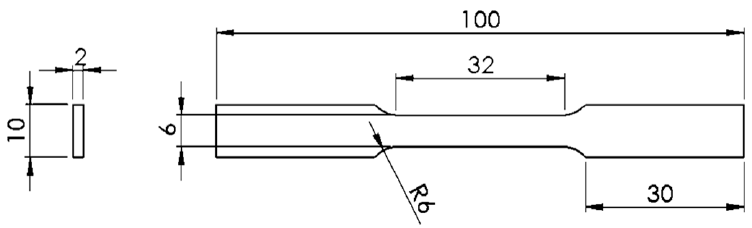
Figure 5. Geometry and dimensions of the specimens for tensile tests.